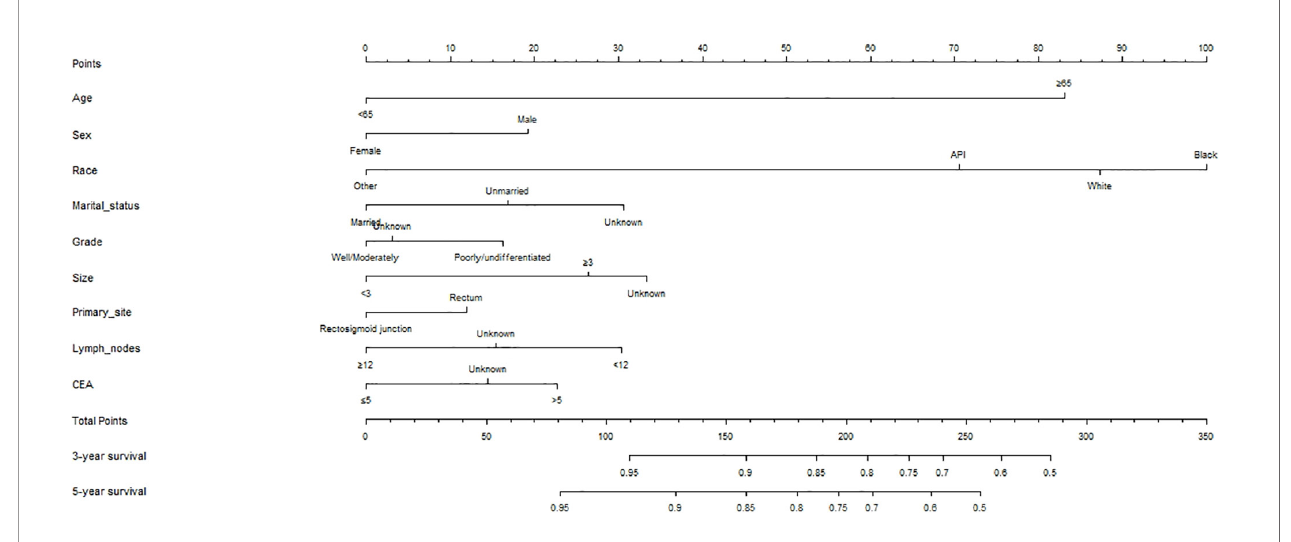
FIGURE 3 | Oncologic nomogram for T3N0 rectal cancer patients after TME.